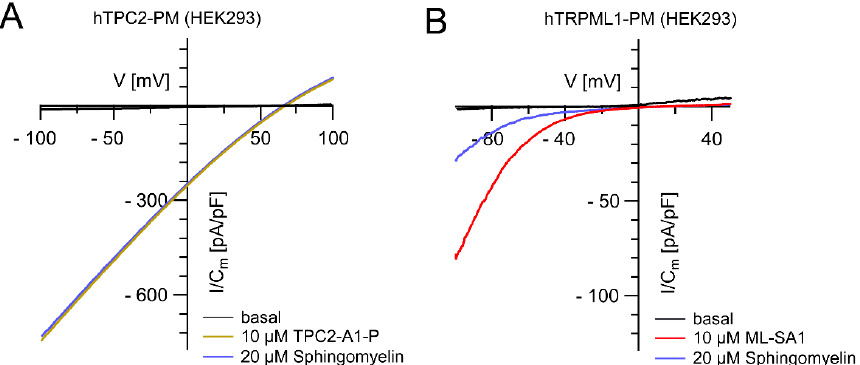
Figure 3. Effect of sphingomyelin on TPC2 and TRPML1 activities. ( A , B ) Representative measurements (I/Cm -V traces) of transiently transfected PM variants of hTPC2 ( A ) and hTRPML1 ( B ) in HEK cells. Channels were activated by small molecule agonists (10 µM TPC2-A1P and 10 µM ML-SA1), respectively. Subsequently, bath solution was completely exchanged for a solution containing agonist plus 20 µM sphingomyelin (SM). Bath solution contained: 138 mM NaCl, 6 mM KCl, 2 mM MgCl 2 , 2 mM CaCl 2 , 10 mM HEPES, and 5.5 mM D-glucose (adjusted to pH 7.4 with NaOH) and pipette solution contained 140 mM K-MSA, 5 mM KOH, 4 mM NaCl, 0.39 mM CaCl 2 , 1 mM EGTA and 20 mM HEPES (pH was adjusted with KOH to 7.2).